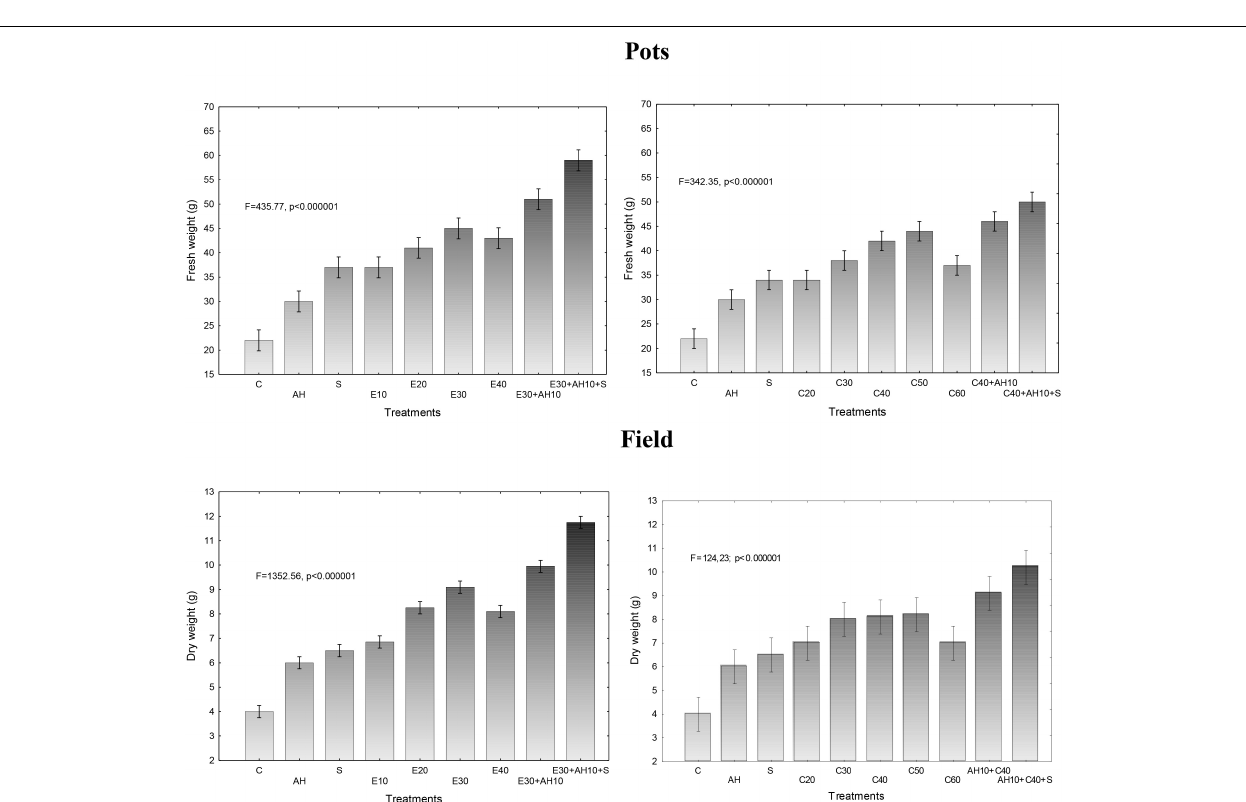
Frontiers in Plant Science |